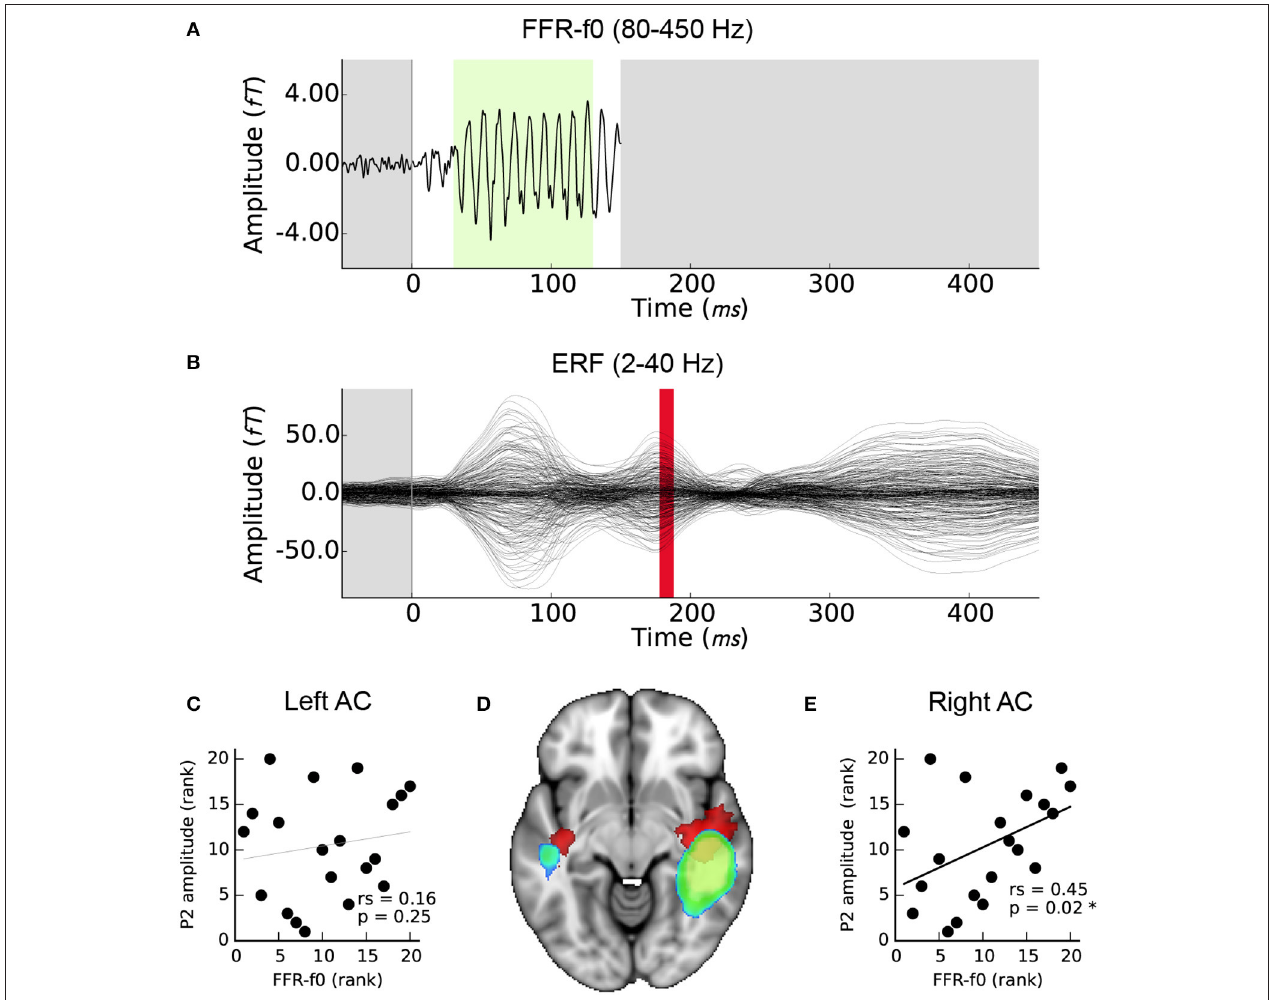
FIGURE 4 | Relationship between FFR-f0 strength (blue-green) and P2 amplitude (red). (A) Time course of the FFR-f0 response, single channel (as presented in Coffey et al., 2016b; 80–450 Hz bandpass filtered; − 50 to 150 ms window). The green portion indicates period over which FFR-f0 strength is calculated. (B) ERF over the same time period; these signals are separated by frequency band (2–40 Hz bandpass filtered) but P2 occurs after the FFR. Correlations between the FFR-f0 strength from the cortical ROIs as measured using MEG and the ERP strength at P2 as measured using EEG are shown for (C) the left and (E) the right auditory cortex. (D) Illustrates the relationship of the cortical origins of each signal (1mm MNI space; cluster threshold; p <